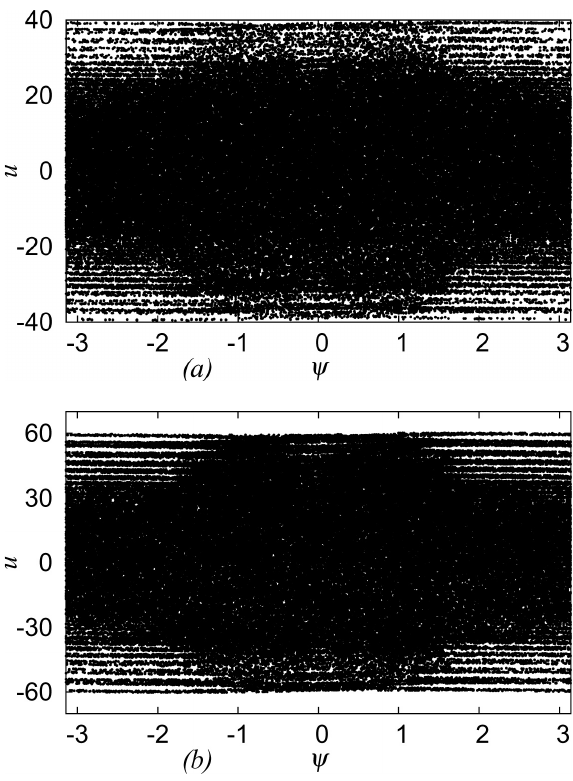
Fig. 3. Phase space for the map g n after 2 × 10 6 iterations with (a) Q = 0 . 5 and (b) Q = 0 .